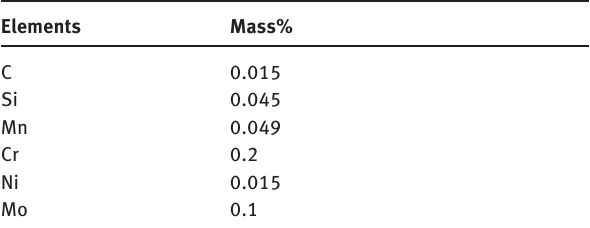
Table 3: Tensile properties of the tube